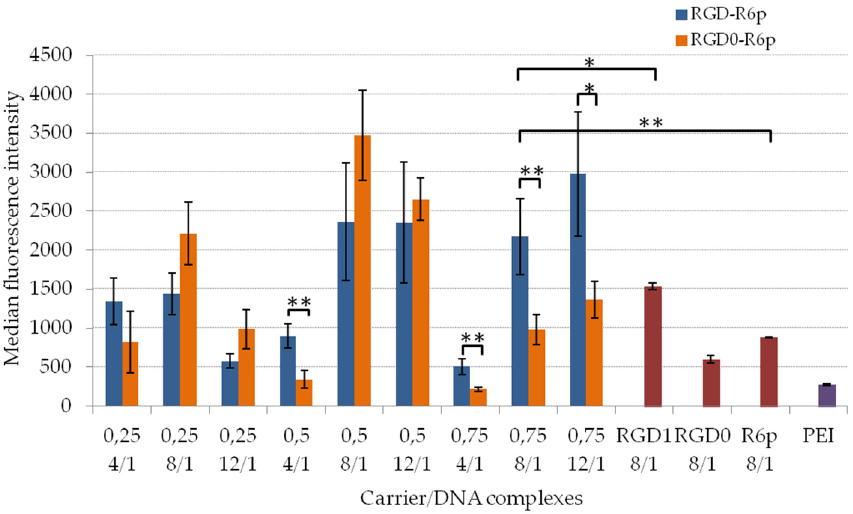
Figure 7. Normalized fluorescence intensity of PANC-1 cells after the uptake of peptide/DNA complexes at 4/1, 8/1 and 12/1 charge ratios labeled with YOYO-1. Values are the mean ± SEM of the mean of triplicates. * p < 0.05, ** p < 0.01 when compared with R6p/DNA polyplexes.